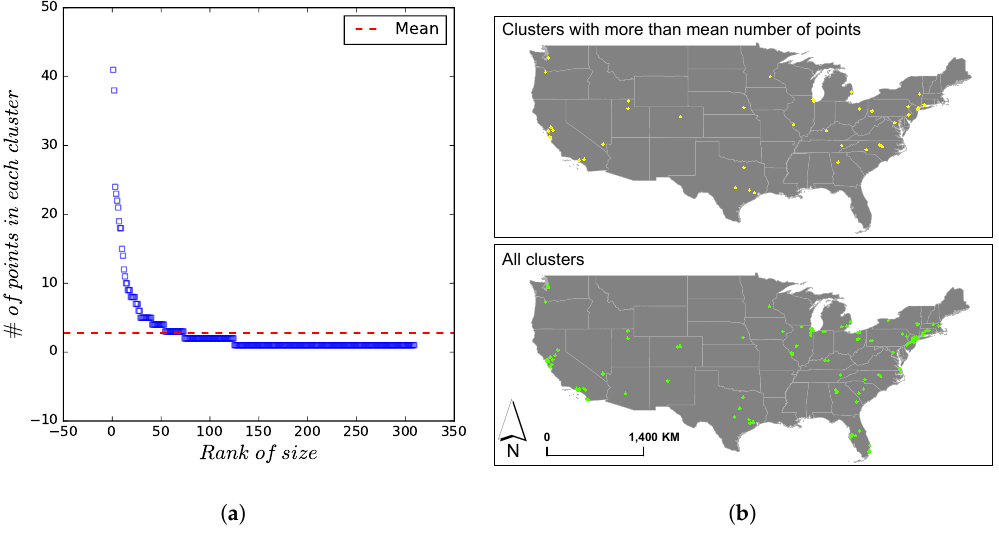
Figure 7. Distributions of spatial clusters. ( a ) distribution of number of points over clusters; ( b ) geospatial